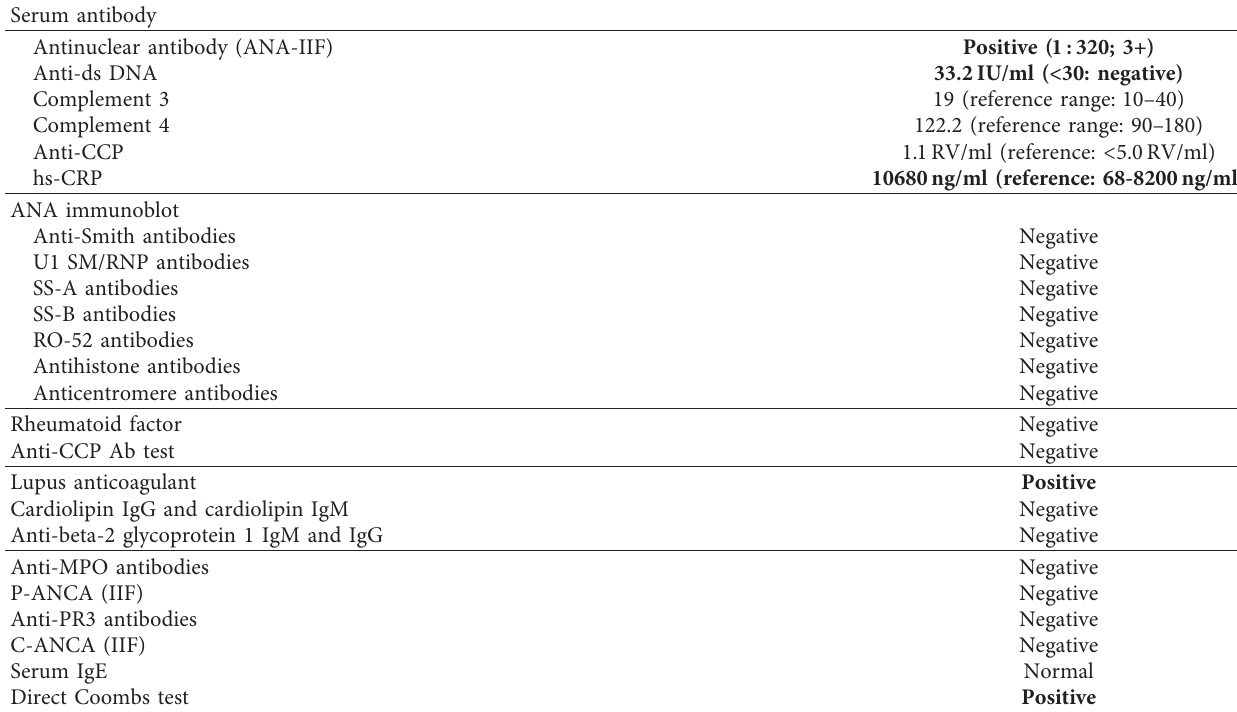
Table 2: Serum antibody testing and its results of the patient.